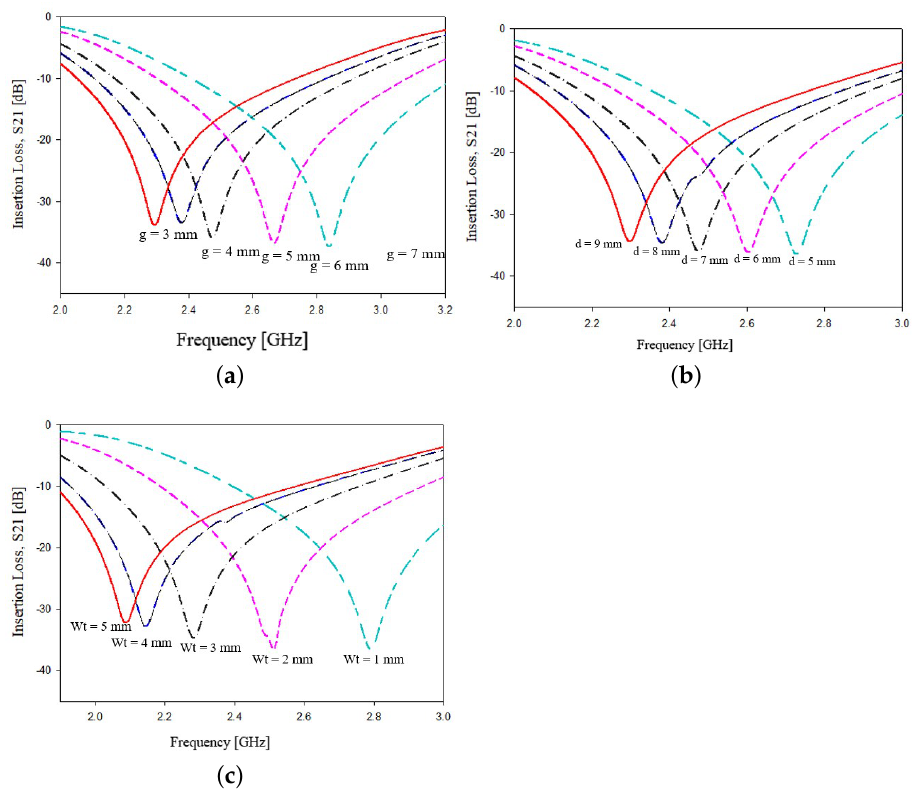
Figure 6. Dependence of the main frequency peak versus variations of geometrical parameters, with reference to Figure 5: ( a ) gap between the stubs g , ( b ) length of stubs tips d and ( c ) width of the stubs tips W t